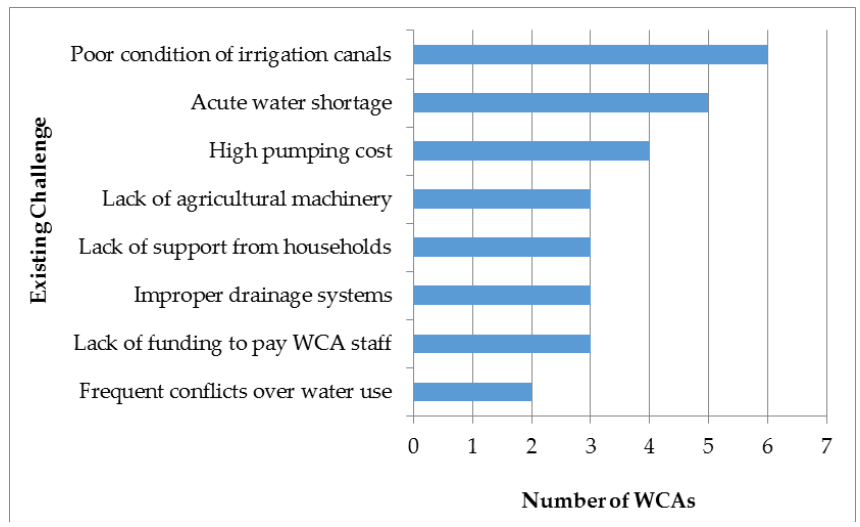
Figure 3. Key challenges identified by the study participants.